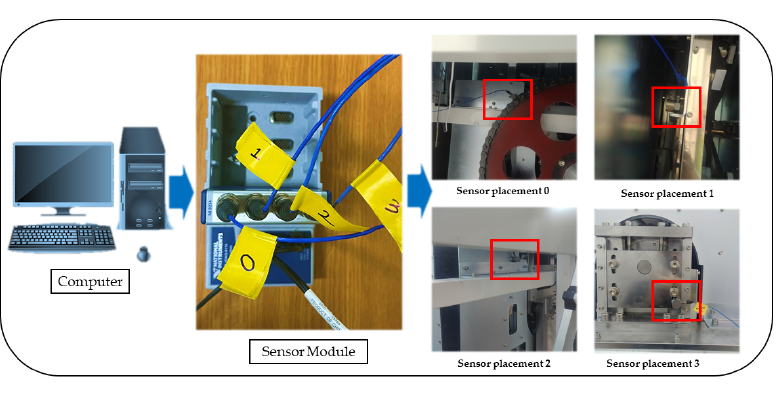
Figure 5. Identification of the vibration sensor placement on the vertical carousel storage and retrieval system.